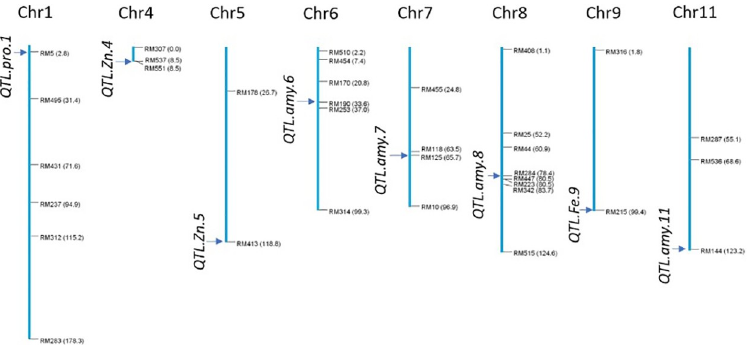
Fig 4. QTL map showing eight significant markers for four phenotypic traits in 113 aromatic rice germplasm.